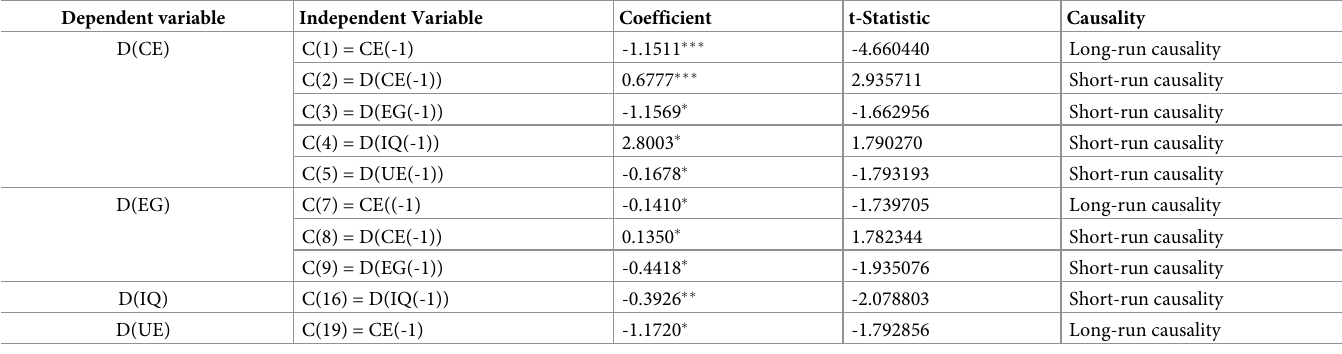
Table 8. Causality test—t-statistic approach.